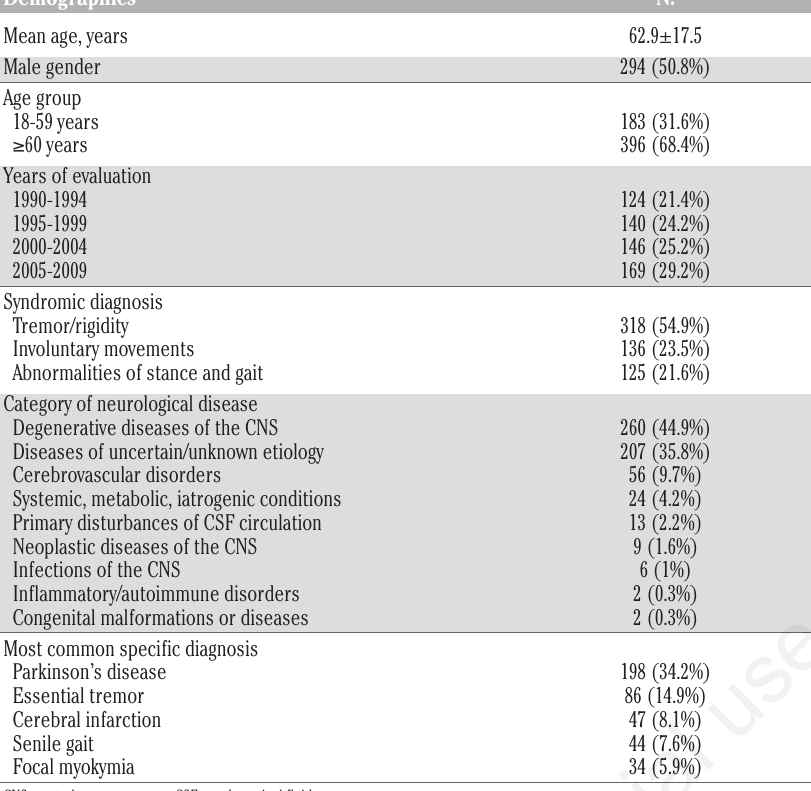
Table 1. Characteristics of 579 outpatients presenting with movement disorder.